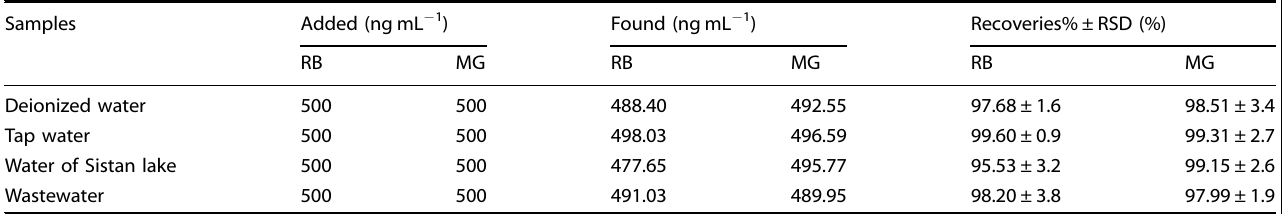
Table 2. Spiked recoveries (%) of real water samples. Samples